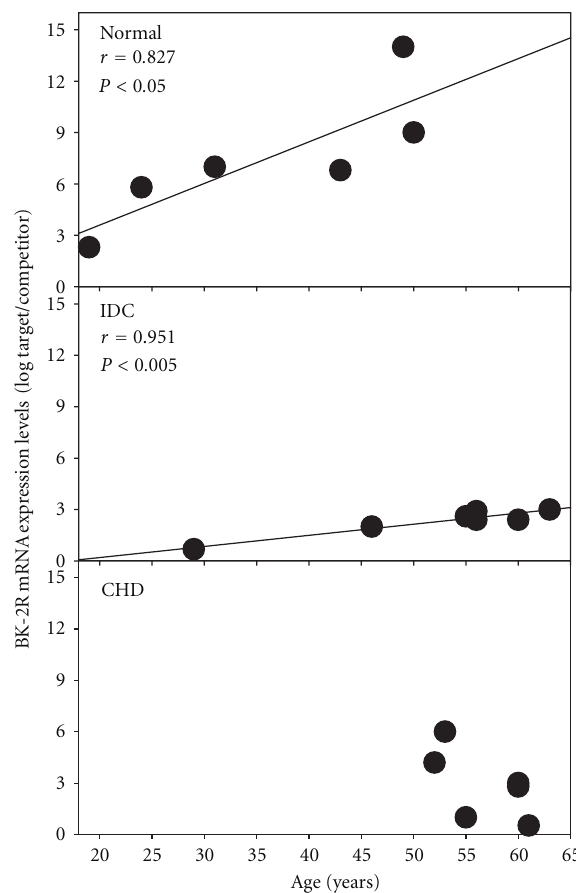
Figure 1: BK-2R mRNA expression correlates with age in normal and failing (IDC) hearts. The level of BK-2R mRNA expression was plotted against age of normal, IDC, and CHD hearts, and the correlation was calculated. P < 0 . 05 was considered